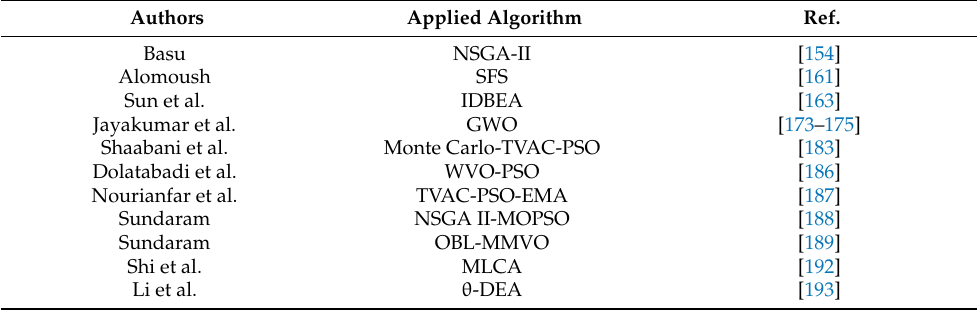
Table 10. Economic emission dispatching issues of CHP energy systems (CHPEED optimization